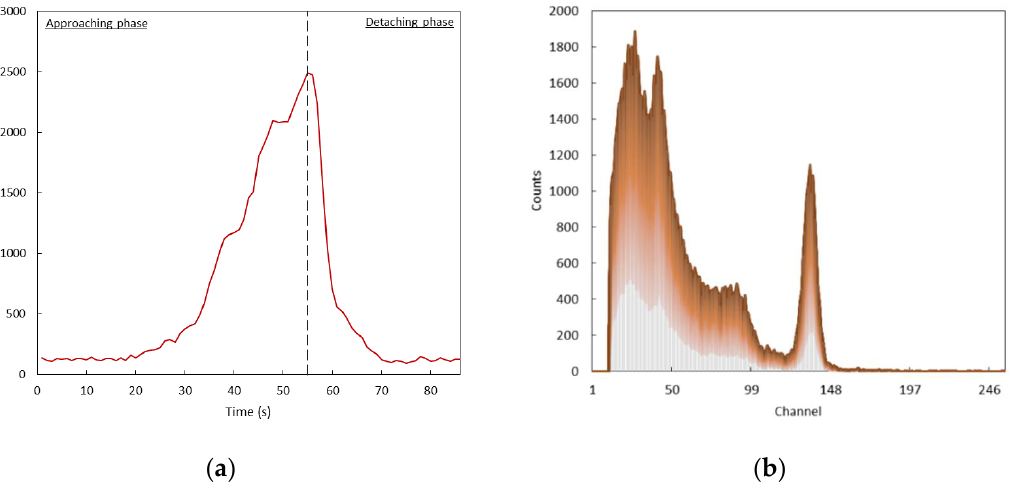
Figure 14. Results of the in-flight testing of the detection system showing the curve corresponding to the detected activity during the ( a ) and the collected spectrum during the flight ( b ).